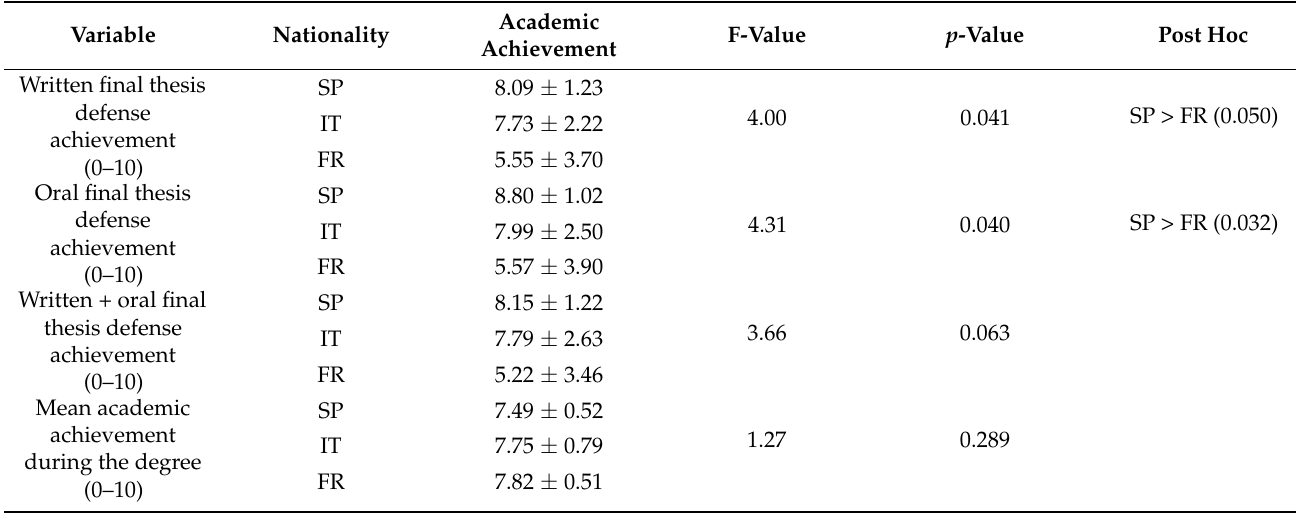
Table 3. Academic achievement in the written final thesis defense, oral final thesis defense, written + oral final thesis defense and mean academic achievement during the degree according to different nationality. Data are mean ± SD.